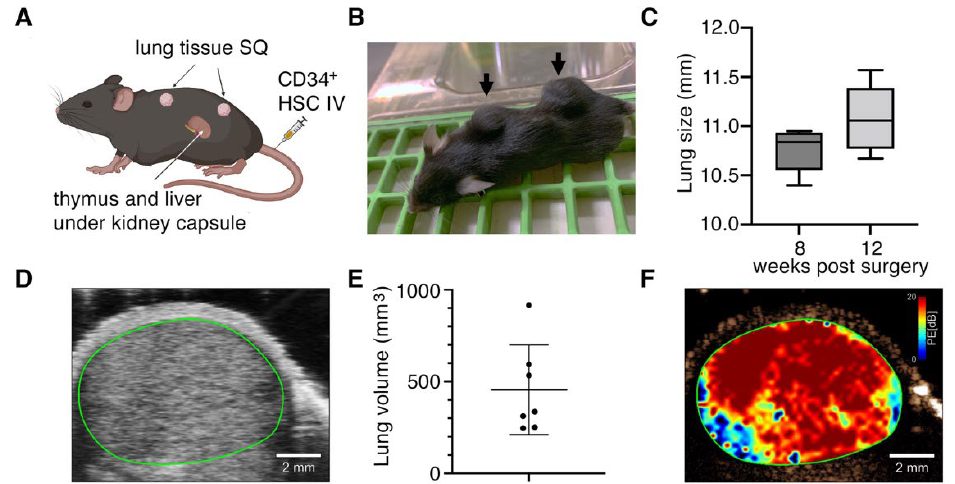
Figure 1. Implanted human lung tissue develops into well vascularized subcutaneous lung organoids on TKO-BLT mice. ( A ) Schematic of humanization procedure to produce TKO-BLT-L mice. Created with BioRender.com. ( B ) Representative mouse with subcutaneous lung organoids established on the upper and lower back (arrows). ( C ) Average lung diameter at 8- and 12- weeks post-surgery (wps) ±SD ( n = 8 8, p = 0.13). ( D ) Representative B-mode ultrasound imaging of subcutaneously implanted lung organoid (green line) ( n = 5 ). ( E ) 3D-scans were used to determined implant volumes with an average of 455.7 ± 243.8 mm 3 ( n = 7 ) and ( F ) Representative perfusion map generated from implanted lung organoids ( n = 5 ). Data in D-F collected at 15–24 wps.